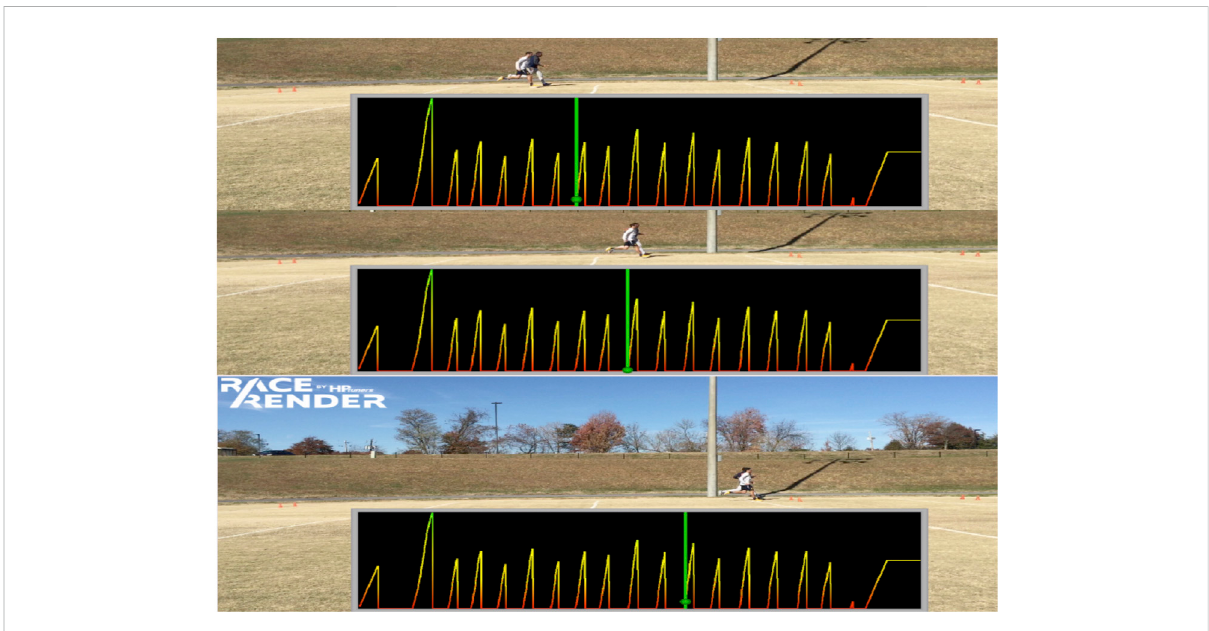
FIGURE 2 Sequential images and sparklines on eachpanel represent acceleration data during arunning trial. *Video and acceleration data were uploaded to and synchronized using RaceRender software. *Sequential images show the research assistant (far side) and a participant (near side) performing a running trial. *Sparklines represent acceleration data, the initiation of a spike is an onset of a new acceleration and was associated with heel strikes and toe-off on videos to count